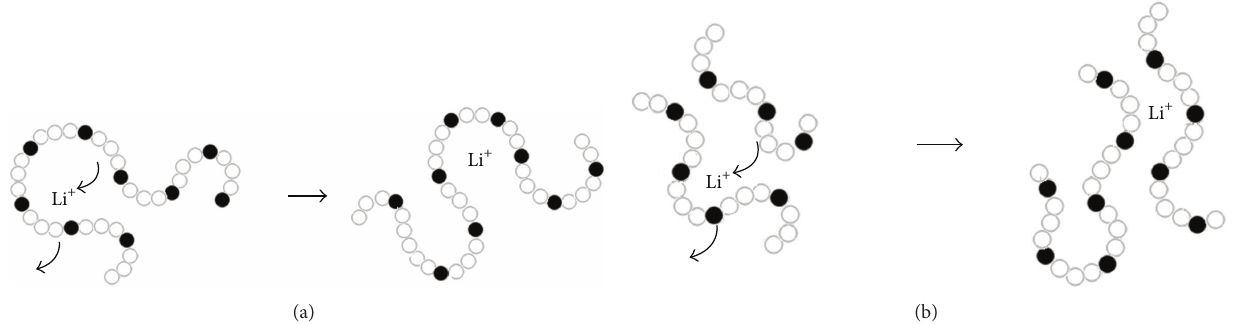
Figure 7: Local segmental motion: (a) intrachain motion and (b) interchain motion.